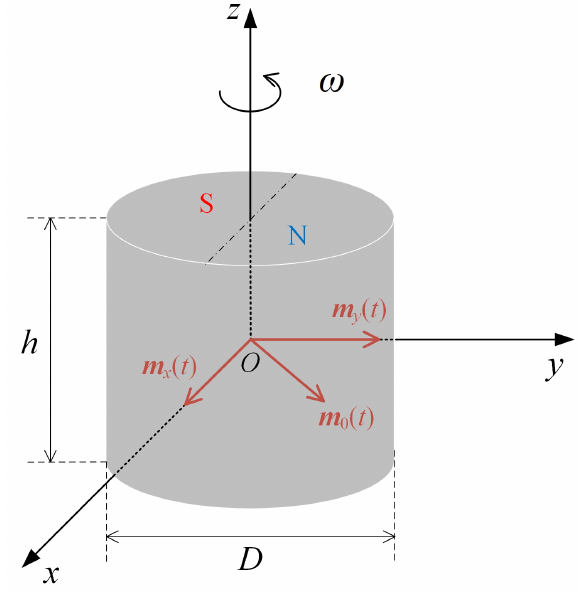
Figure 1. Equivalent model of a single rotating permanent magnet.